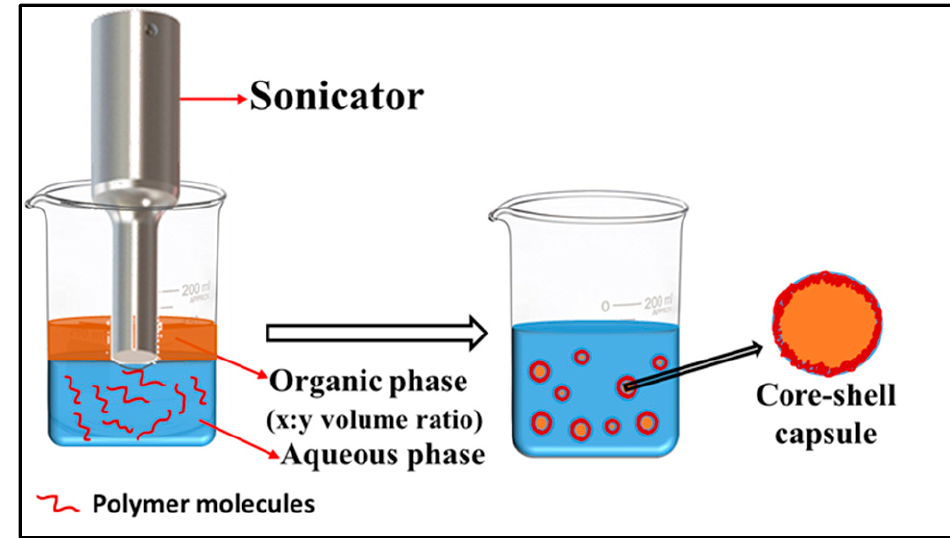
Figure 5. Schematic diagram of ultrasonication-assisted emulsification-coacervation.